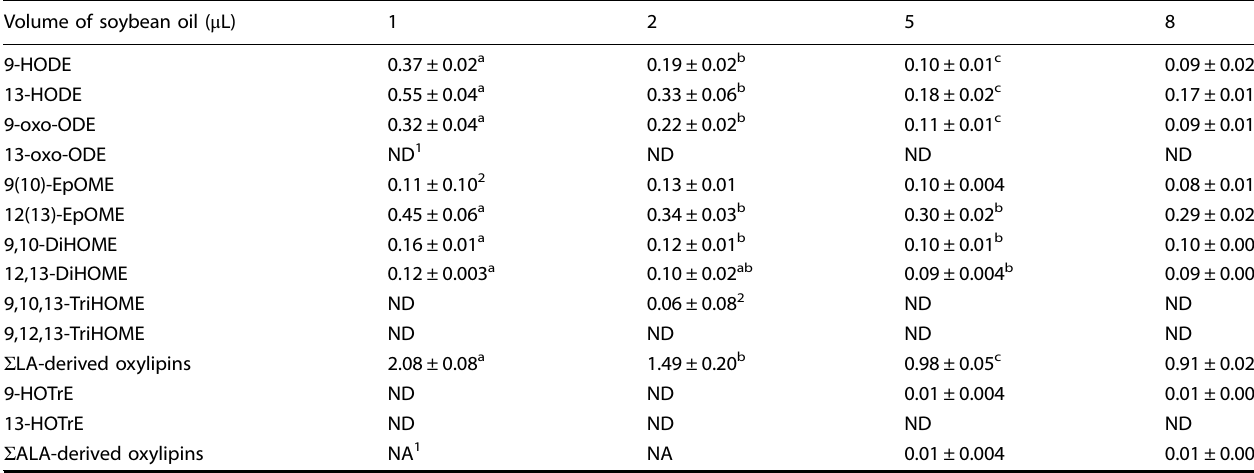
Table 2. Concentrations of free linoleic acid (LA)-derived and α -linolenic acid (ALA)-derived oxylipins in different volumes of soybean oil (pmol/ μ L). Volume of soybean oil ( μ